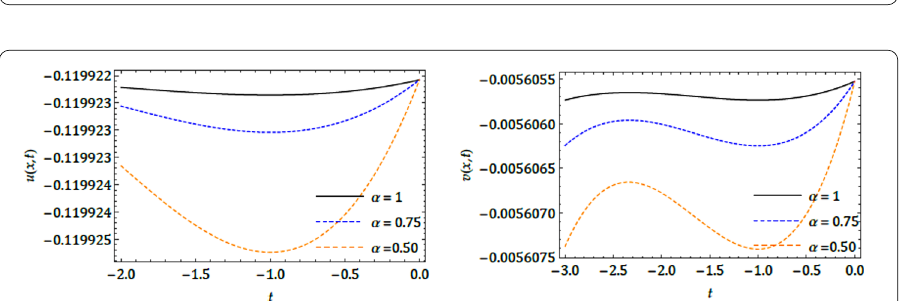
Figure 16 (cid:2) -curves drown for u ( x , t ) at n = 1 (left) and n = 2 (right) for Example 6.2 at ω = 0.005, (cid:13) = 0.1, c = 10, x = 1 and t = 0.01 with diverse α